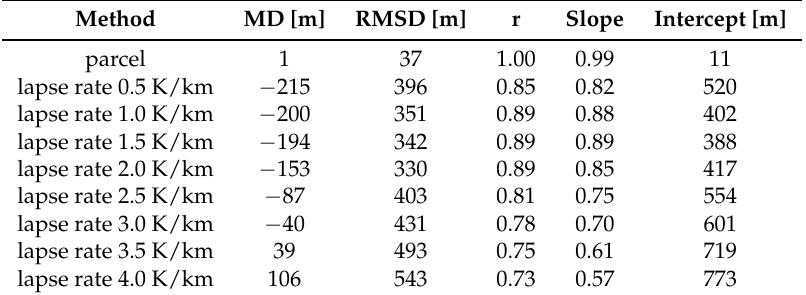
Figure 2. Inter-comparison of the three radiosonde-based MLH methods. The correlation matrix ( a ) shows correlation coefficients in the upper-right triangle, the diagonal shows a histogram of each method, and the lower-left triangle shows scatter-plots and linear regression lines with corresponding 95% confidence intervals. The box and whisker plot (in the style of Tukey) is on plot ( b ). The box lines correspond to the 25, 50 and 75 percentiles. The lower and upper whiskers represent the lowest values still within 1.5 IQR (inter-quantile range) of the lower quartile, and the highest values still within 1.5 IQR of the upper quartile. The data beyond the end of the whiskers signify outliers and are plotted as black dots. White dots indicate mean values. In both figures, atmospheric pressure is color-coded as “High” (blue), “Low” (yellow), “Normal” (green). Table 1. Skill scores (MD—mean deviation; RMSD—root-mean-square deviation, r—Pearson correlation coefficient, slope—linear regression slope, intercept—linear regression intercept) of parcel and lapse rate methods compared against the Richardson method as a reference in the MLH